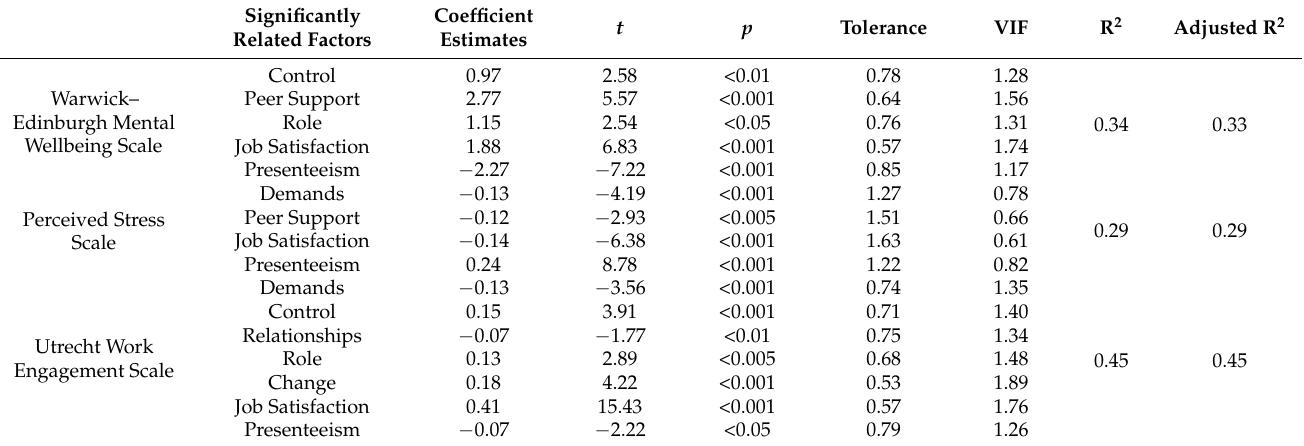
Table 3. Regression analyses of the impact of working conditions on psychological wellbeing, perceived stress, and work